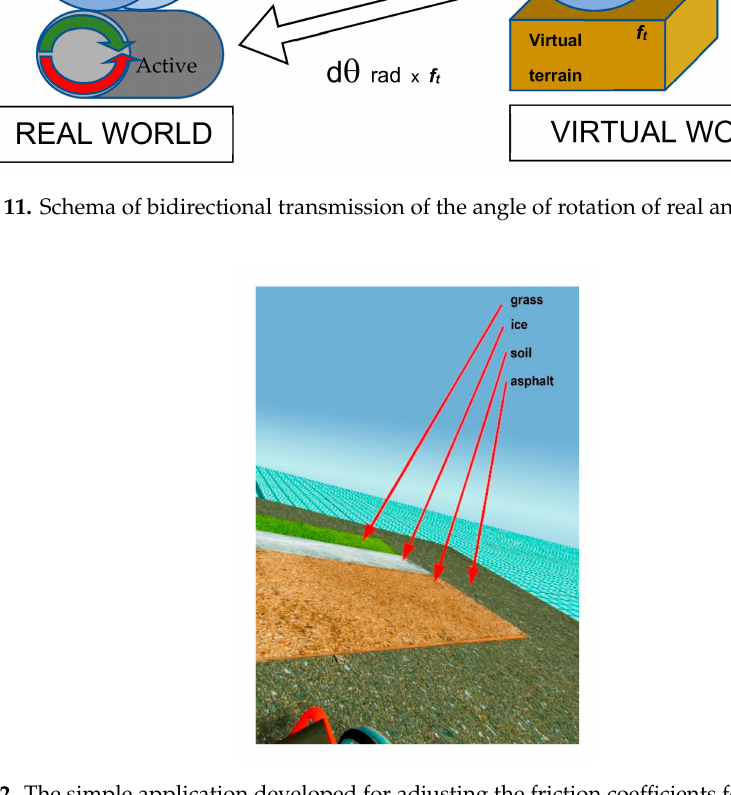
Figure 12. The simple application developed for adjusting the friction coe ffi cients for several grounds: “grass”, “ice”, “soil”, and